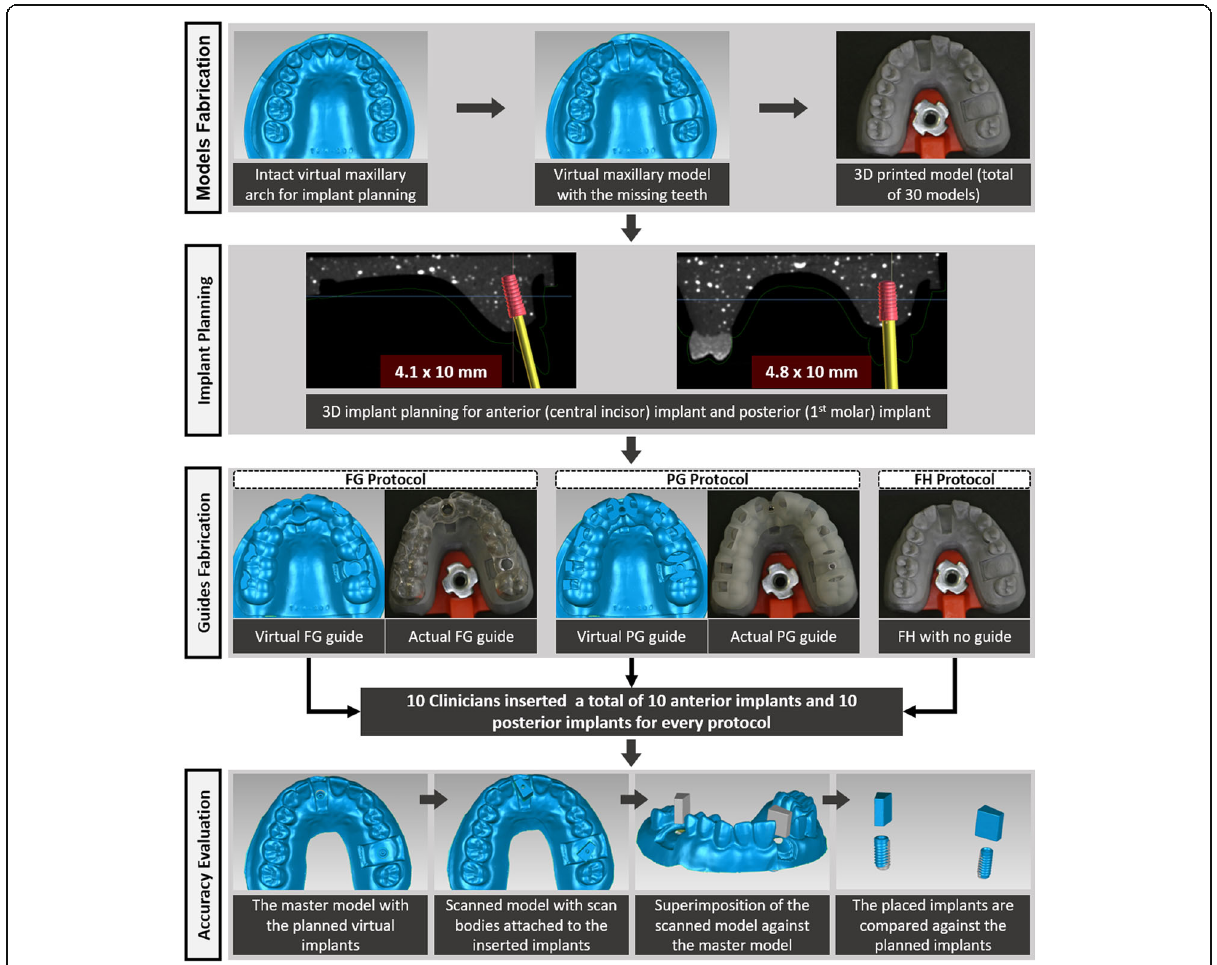
Fig. 1 Flowchart summarizing the different phases of the